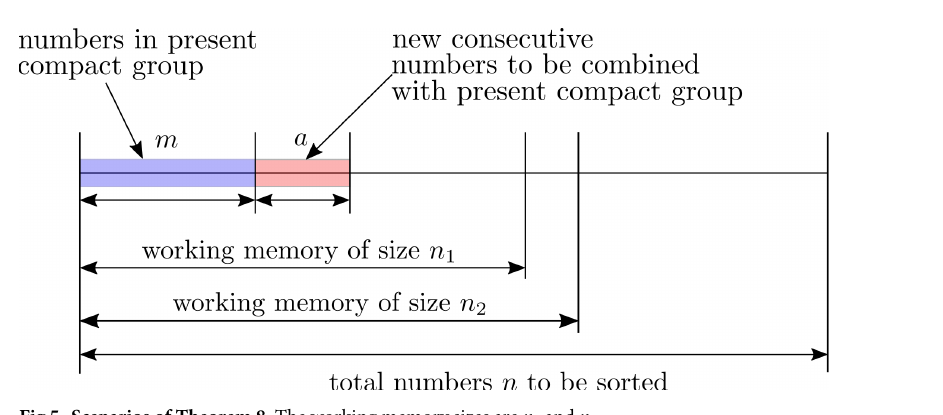
Fig 5. Scenarios of Theorem 8. The working memory sizes are n 1 and n 2